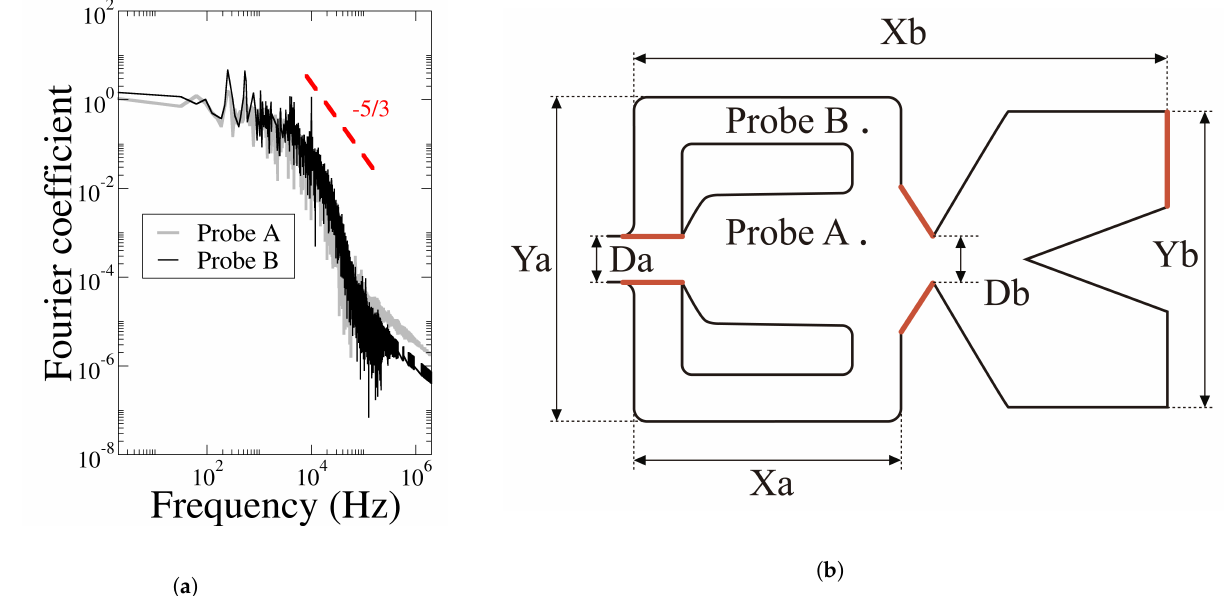
Figure 3. ( a ) Energy spectrum obtained from two probes located respectively at Probe A ( x = 0.06642 m, y = 0.001693 m, z = 0.00195 m) and Probe B ( x = 0.06642 m, y = 0.010157 m, z = 0.00195 m). ( b ) Probe locations and main